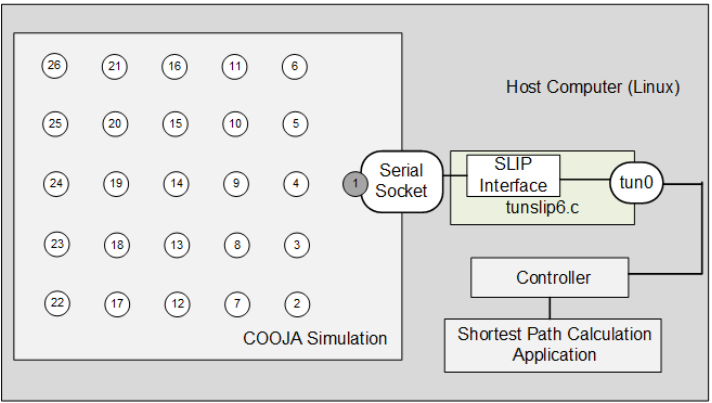
Figure 23. COOJA simulation and SD6WSN controller integration.